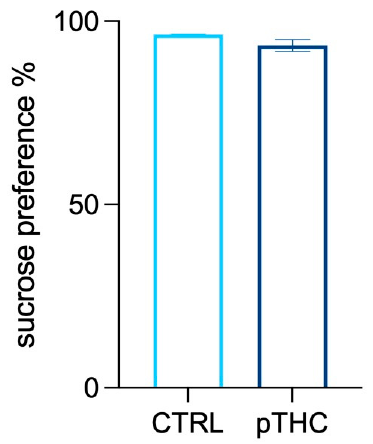
Figure 4. Effects of prenatal TCH exposure (2 mg/kg) on the responsivity to natural reinforcing stimuli of the adolescent male rat offspring in the sucrose preference test. Prenatal exposure to THC did not affect sucrose preference, calculated as the percentage of the volume of the sucrose solution intake divided by the total fluid volume (water plus sucrose). Each bar represents the mean of n = 9 rats in the CTRL group and n = 8 rats in the pTHC group; error bars indicate SEM. CTRL = male rat offspring prenatally exposed to Veh; pTHC = male rat offspring prenatally exposed to THC.